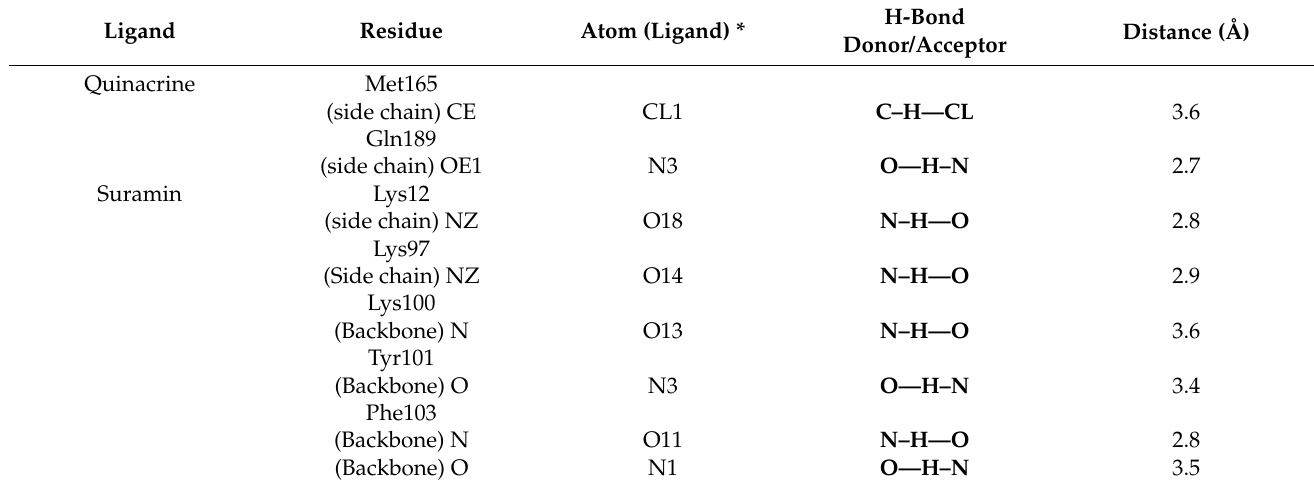
Table 4. Atoms involved in the H-bond interaction between SARS-CoV-2 3CL pro and inhibitors. Ligand